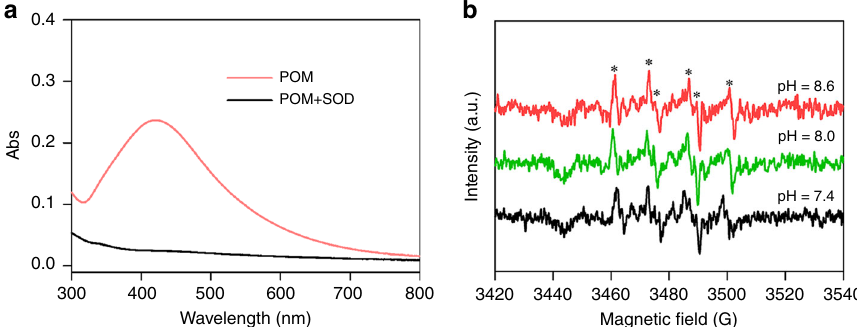
in particulate organic matter suspension. a A dramatic decrease in the SPR absorbance of the AgNPs suspension in the presence of Fig. 4 Production of O (cid:1)(cid:3) 2 150 U SOD mL − 1 , produced by the reduction of 0.93 mM silver ions (Ag + ) with 143.2 mg C L − 1 particulate organic matter (POM) at pH 8.6 under simulated sunlight for 24 h. b EPR spectra of the DMPO adduct with O (cid:1)(cid:3) in POM suspension at different pHs after incubation of the samples under 2 simulated sunlight for 1